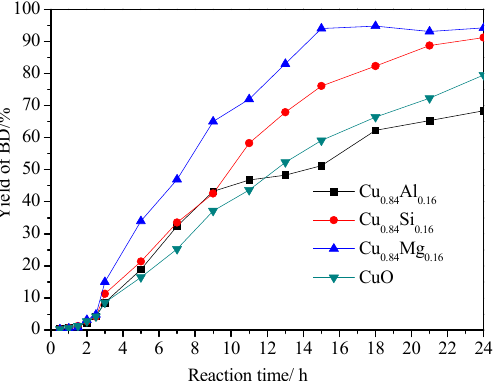
Figure 11. The yield of 1,4-butynediol (BD) by CuO and Cu 0.84 M 0.16 catalysts. Reaction conditions: Catalyst amount, 2.5 g; formaldehyde solution concentration, 35 vol.%; consumption of the formaldehyde solution, 50 mL; reaction temperature, 90°C.